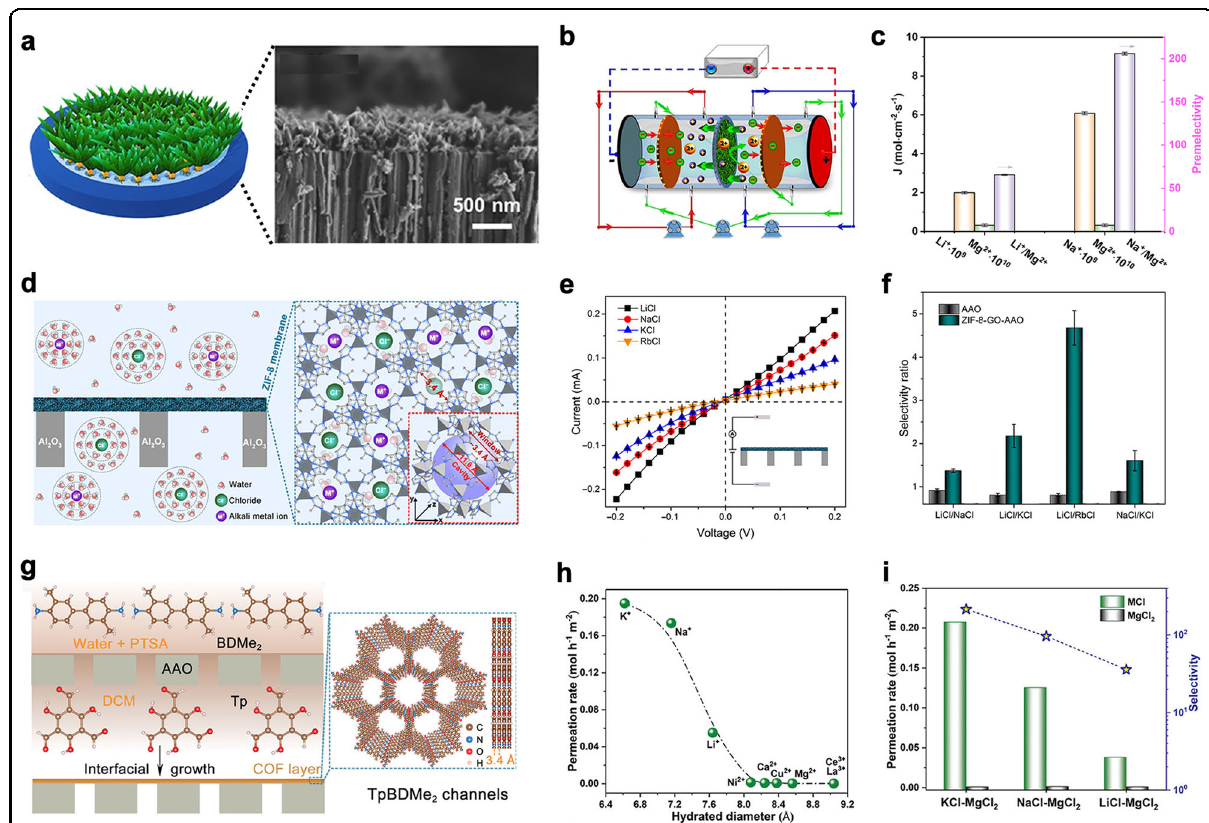
Fig. 4 MOF/COF-based arti fi cial nanochannel membranes with a pore-on-pore structure. a Schematic illustration and SEM cross-sectional images of the UiO-66-NH 2 MOF membrane grown on the AAO support. b Schematic of the voltage-driven cation permselective device. Reproduced with permission 34 . Copyright 2019, Wiley-VCH. c The cation permeation of Na + , Li + , and Mg 2 + and the corresponding permselectivity. d Schematic of the ZIF-8-GO-AAO membrane. I ‒ V curves of the membrane measured in different electrolytes ( e ) and the corresponding ion selectivity ( f ). Reproduced with permission 43 . CC BY 4.0 (https://creativecommons.org/licenses/by-nc/4.0/) g Fabrication of a COF (TpBDMe 2 ) membrane on an AAO support via interfacial growth. h Permeation rates of metal ions vs . hydrated ion diameters. i Monovalent and divalent cation permeation rates and the corresponding selectivity. Reproduced with permission 44 . Copyright 2021,